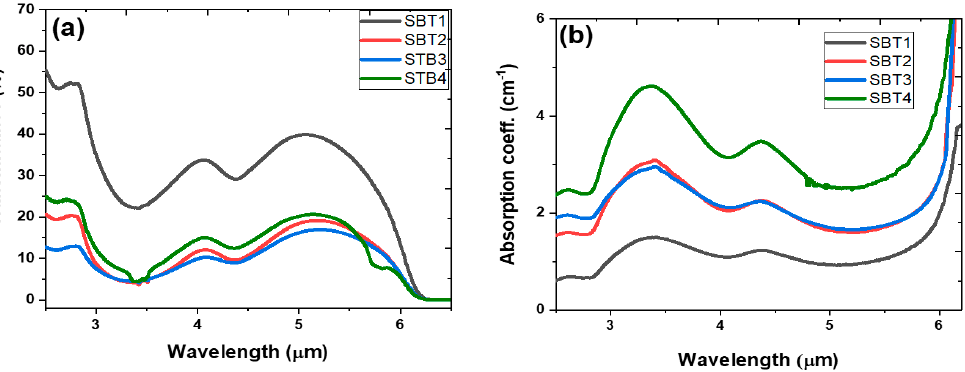
Figure 3. Infrared ( a ) transmission and ( b ) absorption coefficient spectra of Sm 3+ -doped BaF2-TeO2- ZnO glasses by varying Yb 3+ additive concentration.